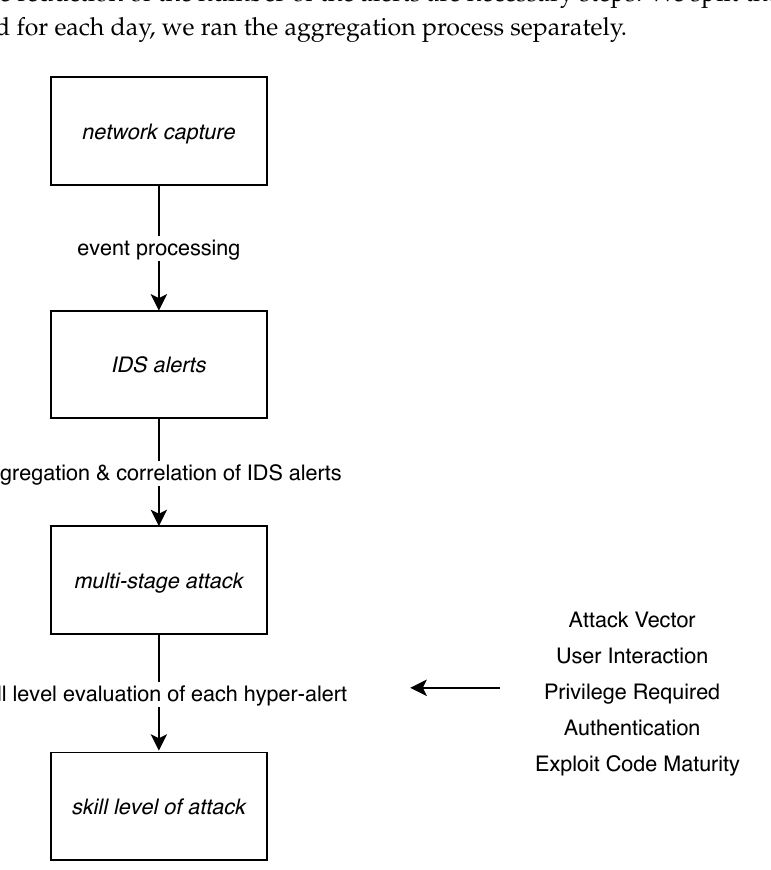
Figure 1. Overview of the processing and evaluation